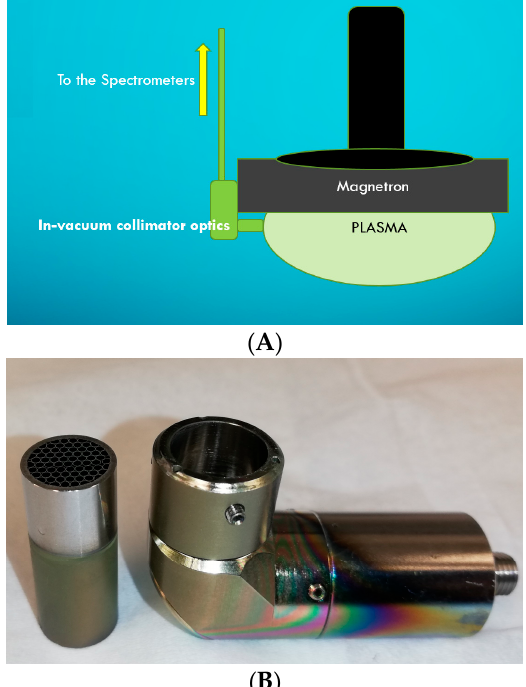
Figure 2. ( A ) In-vacuum collimator optics was placed adjacent to the magnetron and the emission data were transferred to the spectrometers via quartz fiber, the distance between the collimator and target edge was 4 cm. ( B ) The Collimator.